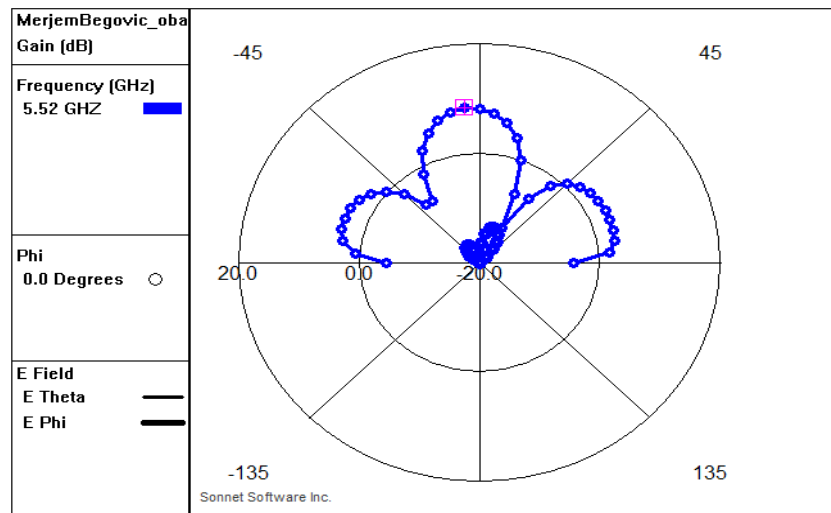
Figure 4. Gain value at 5.52 GHz